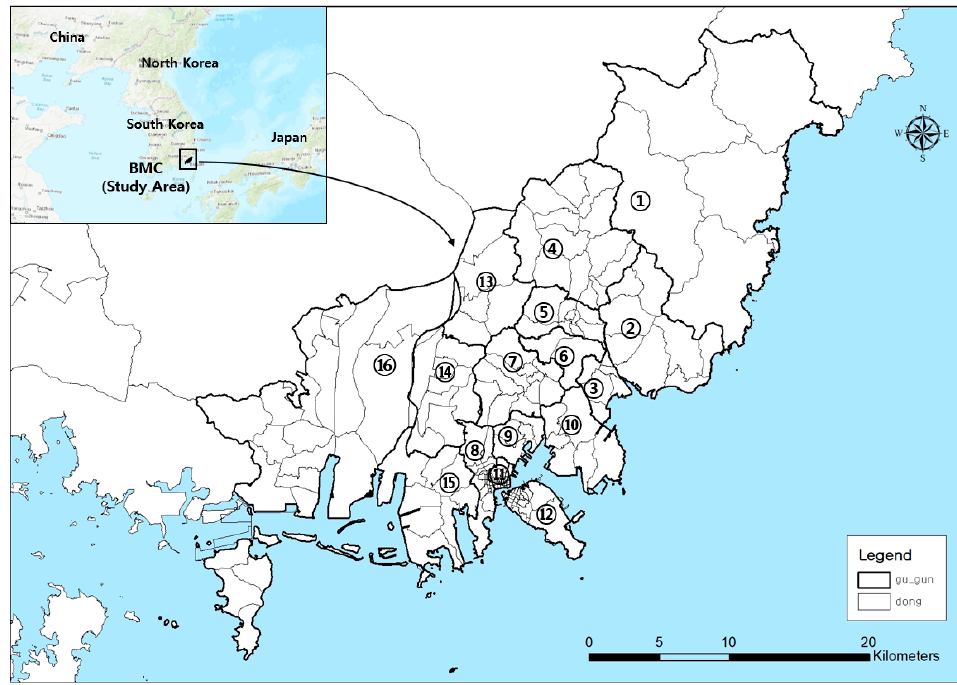
Figure 1. Location and Map of BMC. Note: ① Gijang-gun, ② Haeundae-gu, ③ Suyeong-gu, ④ Geumjeong-gu, ⑤ Dongrae-gu, ⑥ Yeonje-gu, ⑦ Busanjin-gu, ⑧ Seo-gu, ⑨ Dong-gu, ⑩ Nam-gu, ⑪ Jung-gu, ⑫ Yeongdo-gu, ⑬ Buk-gu, ⑭ Sasang-gu, ⑮ Saha-gu, ⑯ Gangseo-gu. The base map was adopted from the National Spatial Data Infrastructure Portal of Korea (www.nsdi.go.kr (accessed on 12 August 2022)). BMC reveals a growth of 20 years as well as a decline of 20 years based on the data